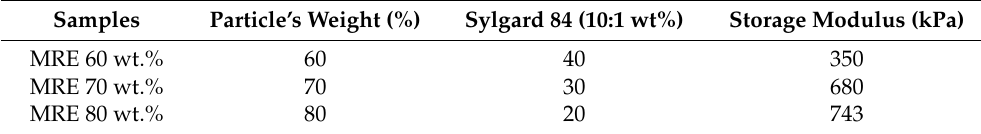
Table 1. Details on the proportions of components and storage modulus of MRE